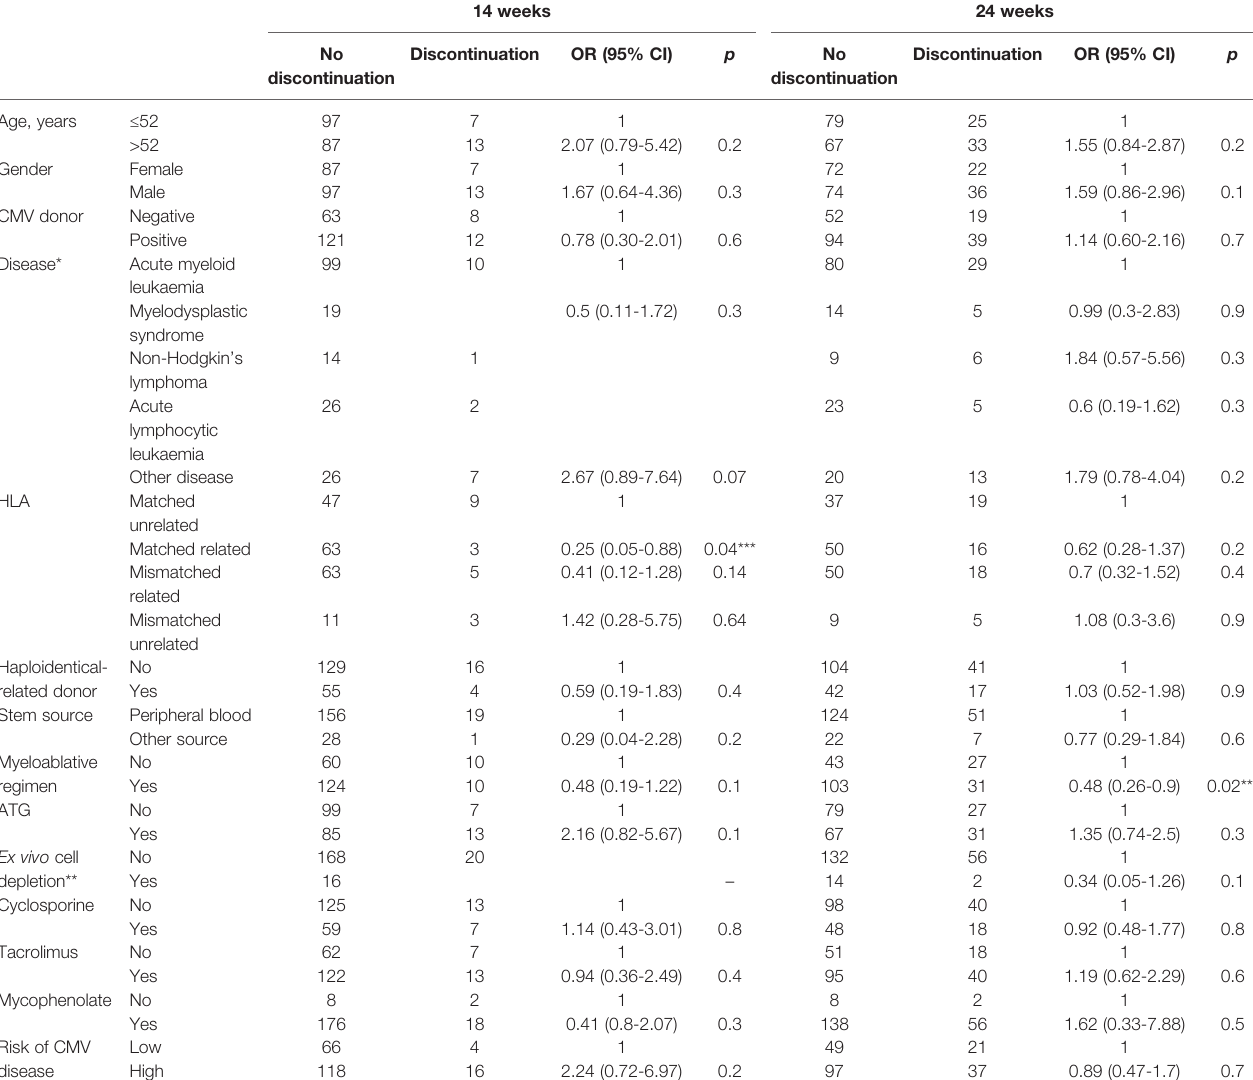
TABLE 4 | Univariate logistic regression analysis of treatment discontinuation through fi rst 100 days and through 168 days by baseline characteristics. 14